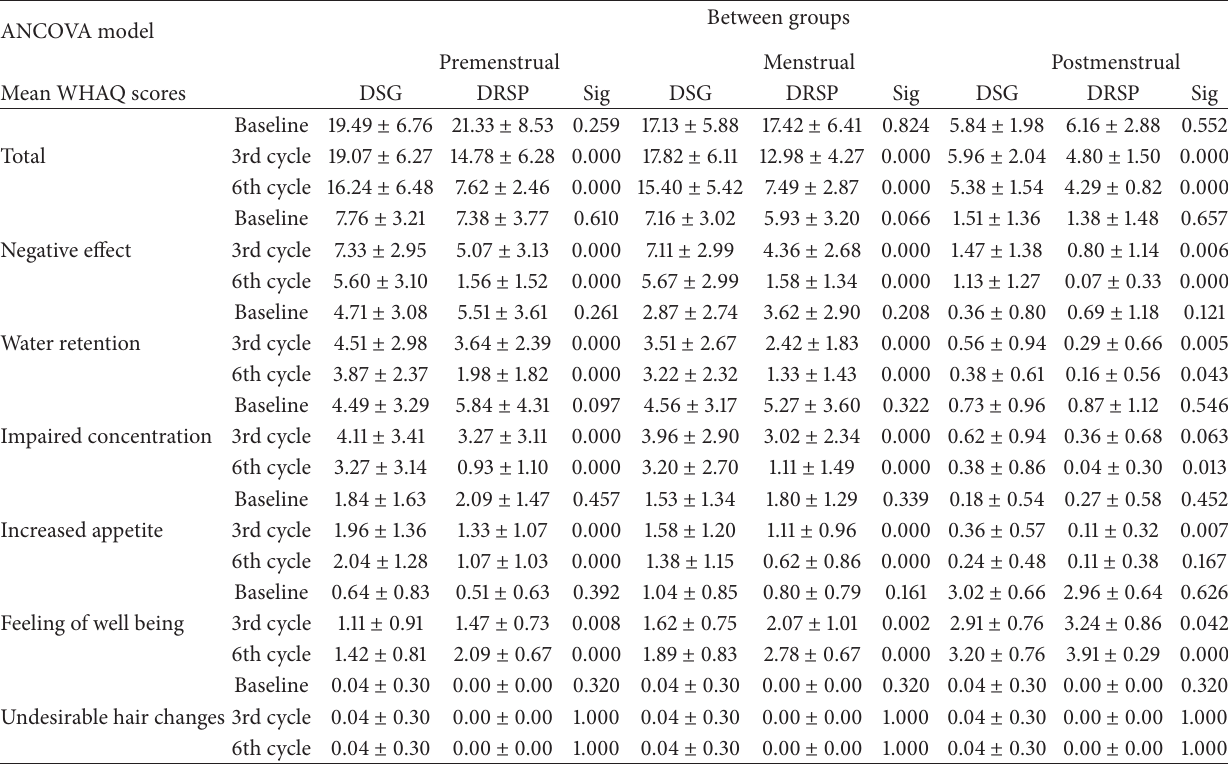
Table 4: The results of group and subgroup analyses according to the comparison of mean WHAQ scores changes between groups. Between groups ANCOVA model Premenstrual Menstrual